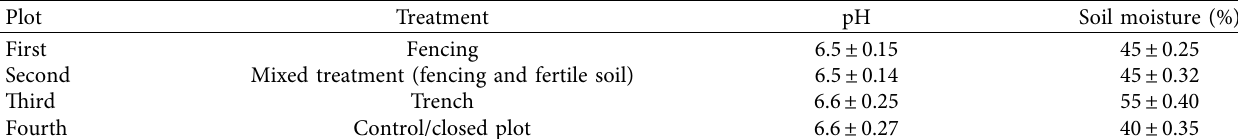
Table 1: Soil pH and moisture of plots of oak forests in Sheshikoh Valley, Chitral.